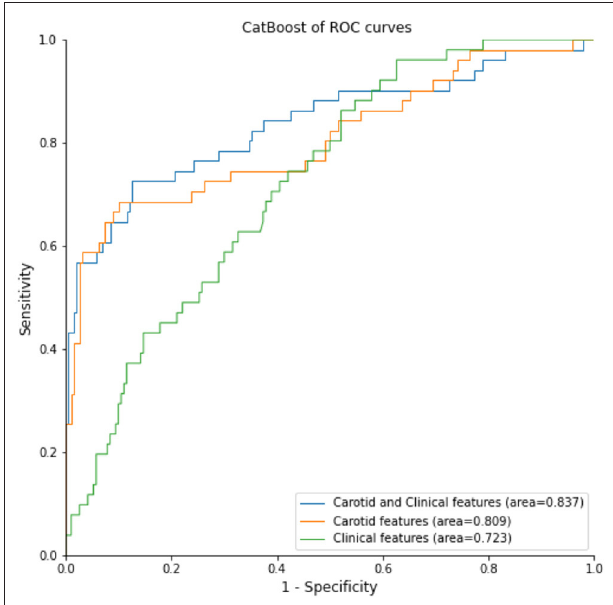
FIGURE 3 | CatBoost model for different settings: clinical data, sonographic data, and combination of clinical and sonographic data for recurrent stroke prediction.